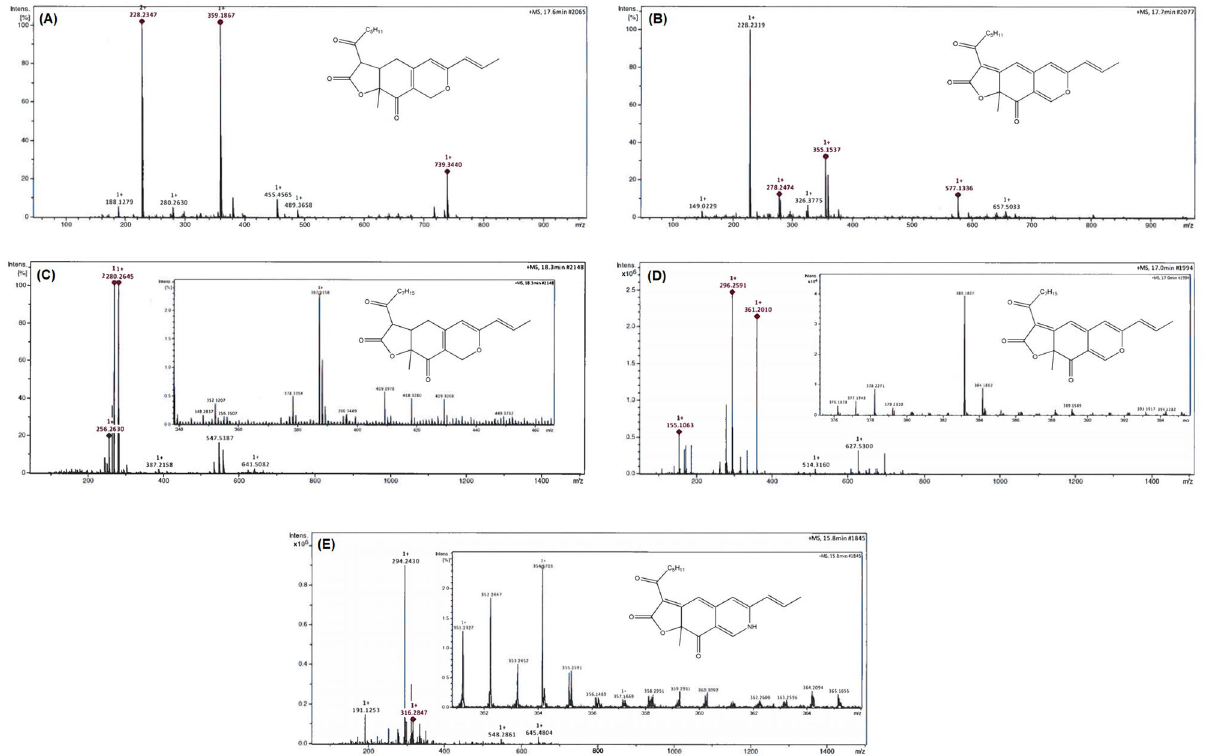
Figure 6. LC/ESI–MS/MS chromatograms of pigments extracted from SSF cultures of the gamma irradiated M. ruber SRZ112. Spectrum and structure of monascin ( A ). Spectrum and structure of rubropunctatin ( B ). Spectrum and structure of ankaflavin ( C ). Spectrum and structure of monascorubrin ( D ). Spectrum and structure of rubropunctamine ( E ).